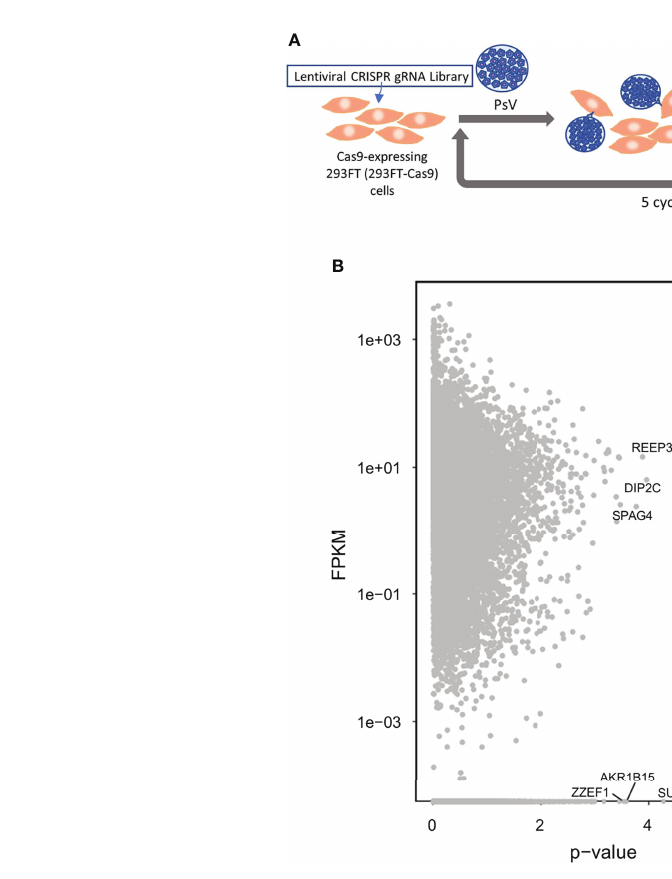
FIGURE 3 | Genome wide CRISPR-Cas9 screening to identify the gene(s) involved in HPV infection. (A) 293FT-Cas9 cells were transduced with lentiviral CRISPR library V1 consisting of 90,709 gRNAs selected with puromycin and then inoculated with HPV PsVs (MOI of 0.8). One day later, cells were selected with ganciclovir. Six days later, surviving cells were re-inoculated with HPV PsVs and selected with ganciclovir. This selection was repeated a total of fi ve times. Enriched gRNAs were analyzed by sequencing. Then, genomic DNA was collected for gRNA sequencing. (B) Dot plot of p-value of the enriched gRNAs with expression level [Fragments per kilobase million (FPKM)]. Red dot shows FDR <